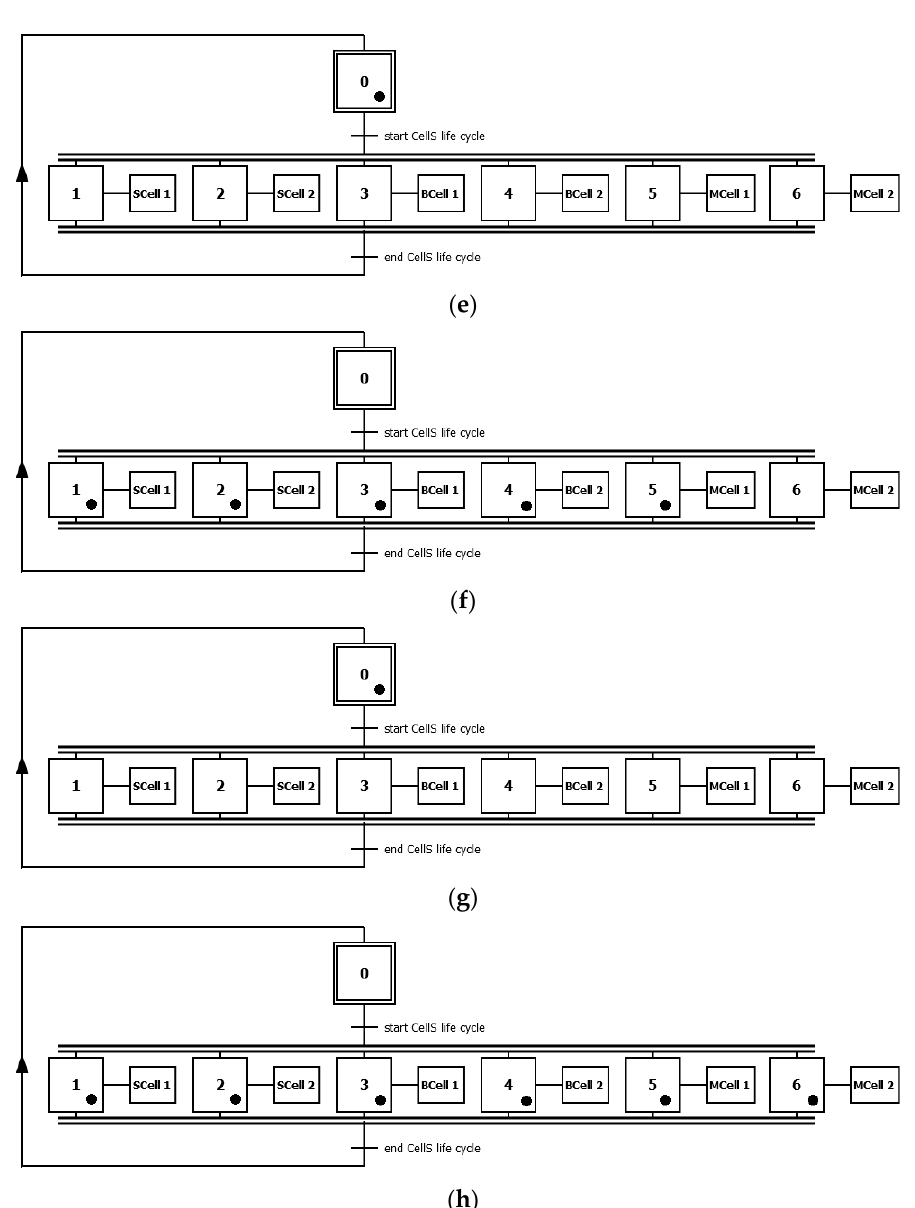
Figure 3. The example of CellS has six cells: ( a ) the initial state of first round; ( b ) SCell 1 and SCell 2 are triggered; ( c ) the initial state of second round; ( d ) SCell 1, SCell 2, and BCell 2 are triggered; ( e ) The initial state of third round; ( f ) SCell 1, SCell 2, BCell 1, BCell 2, and MCell 1 are triggered; ( g ) The initial state of fourth round; ( h ) SCell 1, SCell 2, BCell 1, BCell 2, MCell 1, and MCell 2 are triggered. SCell = sensory cell; BCell = brain cell; MCell = motor cell.